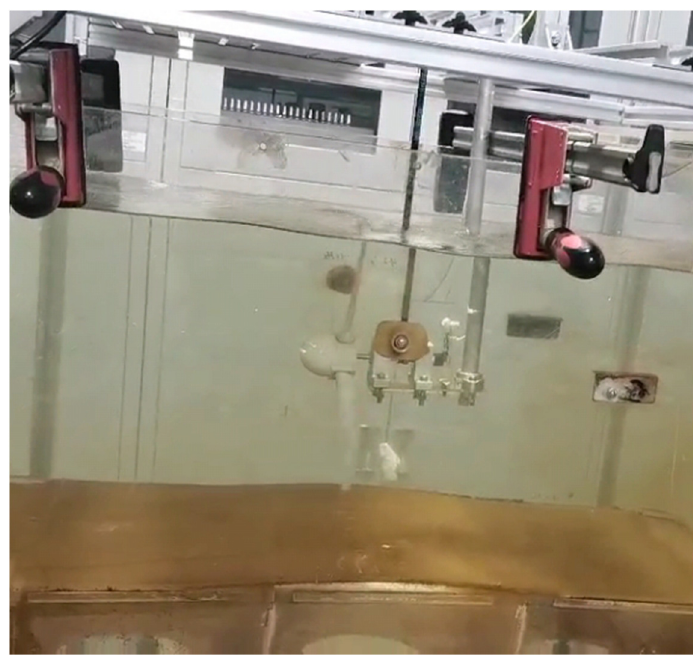
Figure 13. Experimental test platform.